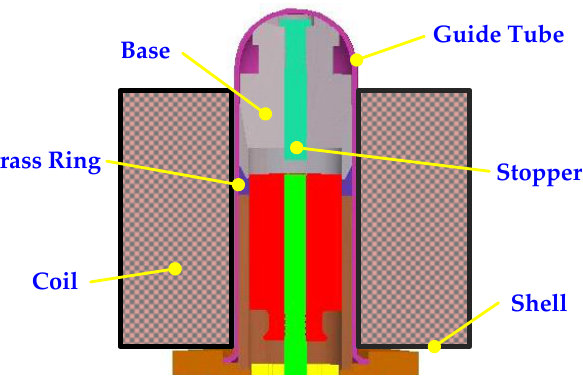
Figure 5. The structure of the proportional electromagnet for a PEHB.